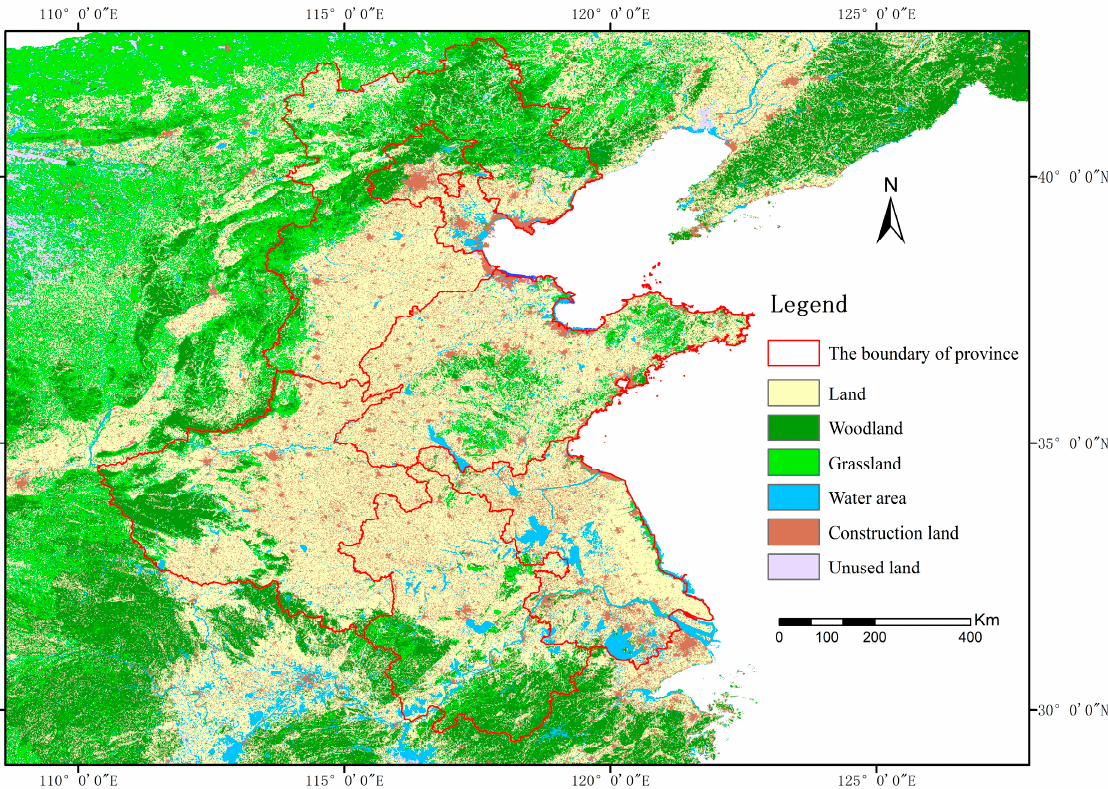
Figure 1. The location of study area and its land use.